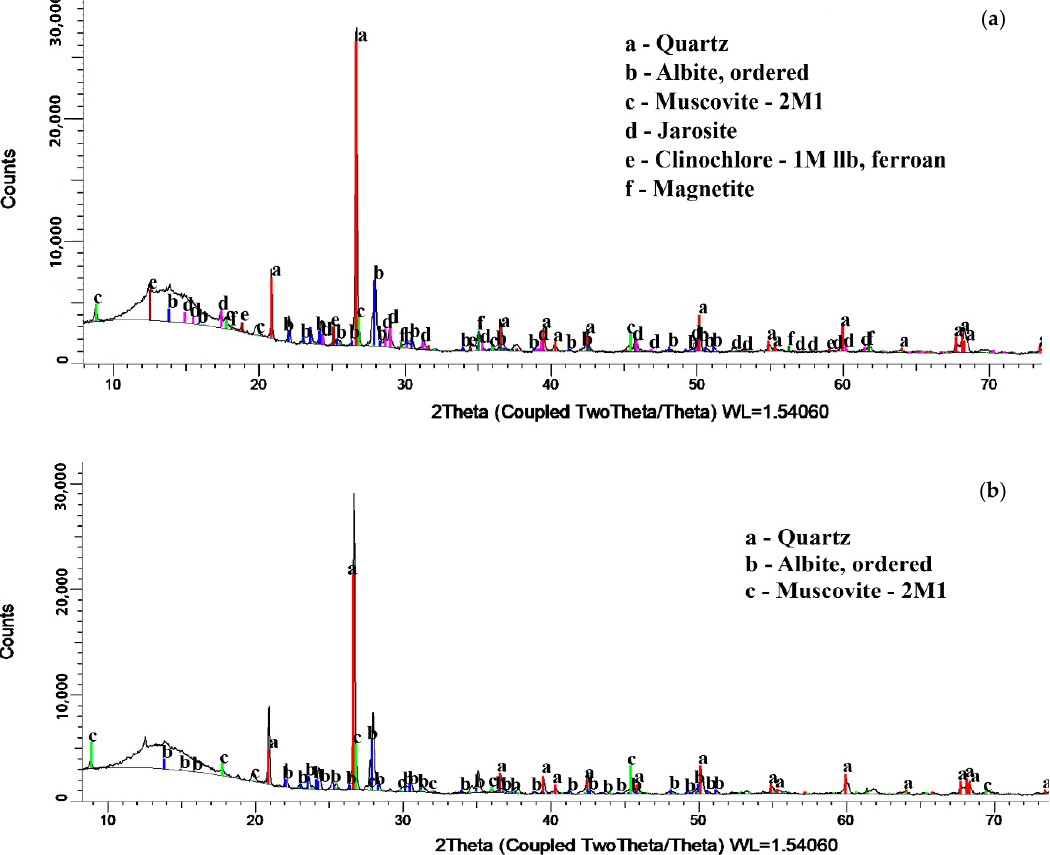
Figure 6. XRD pattern of mine tailings after bioleaching in the flasks with strains A. ferrivorans 535 at 28 °C ( a ) and 8 °C ( b ).